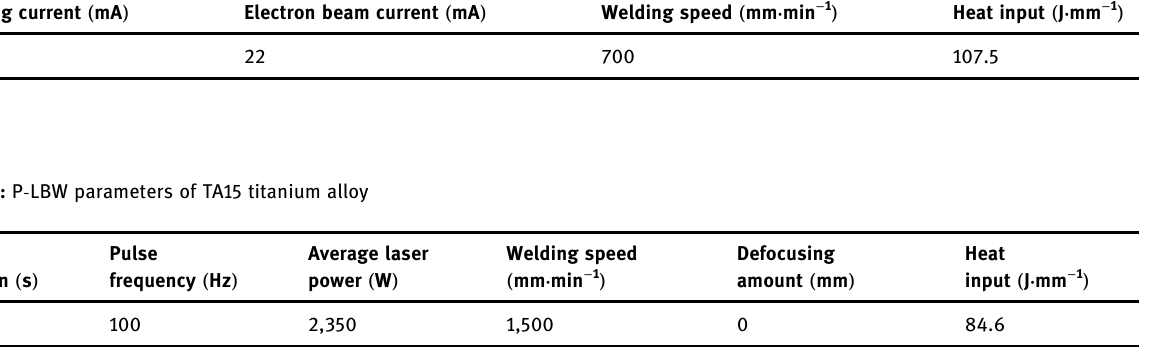
Table 1: EBW parameters of TA15 titanium alloy Focusing current ( mA )